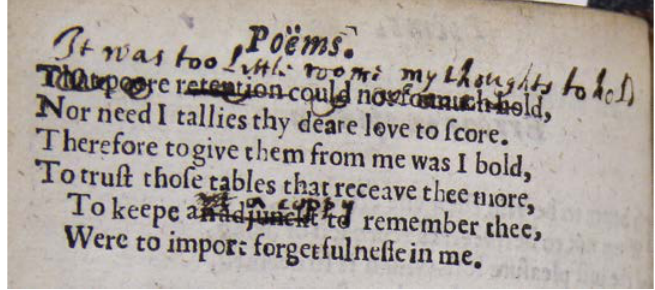
Fig. 10 – Meisei MR 1447, sig.